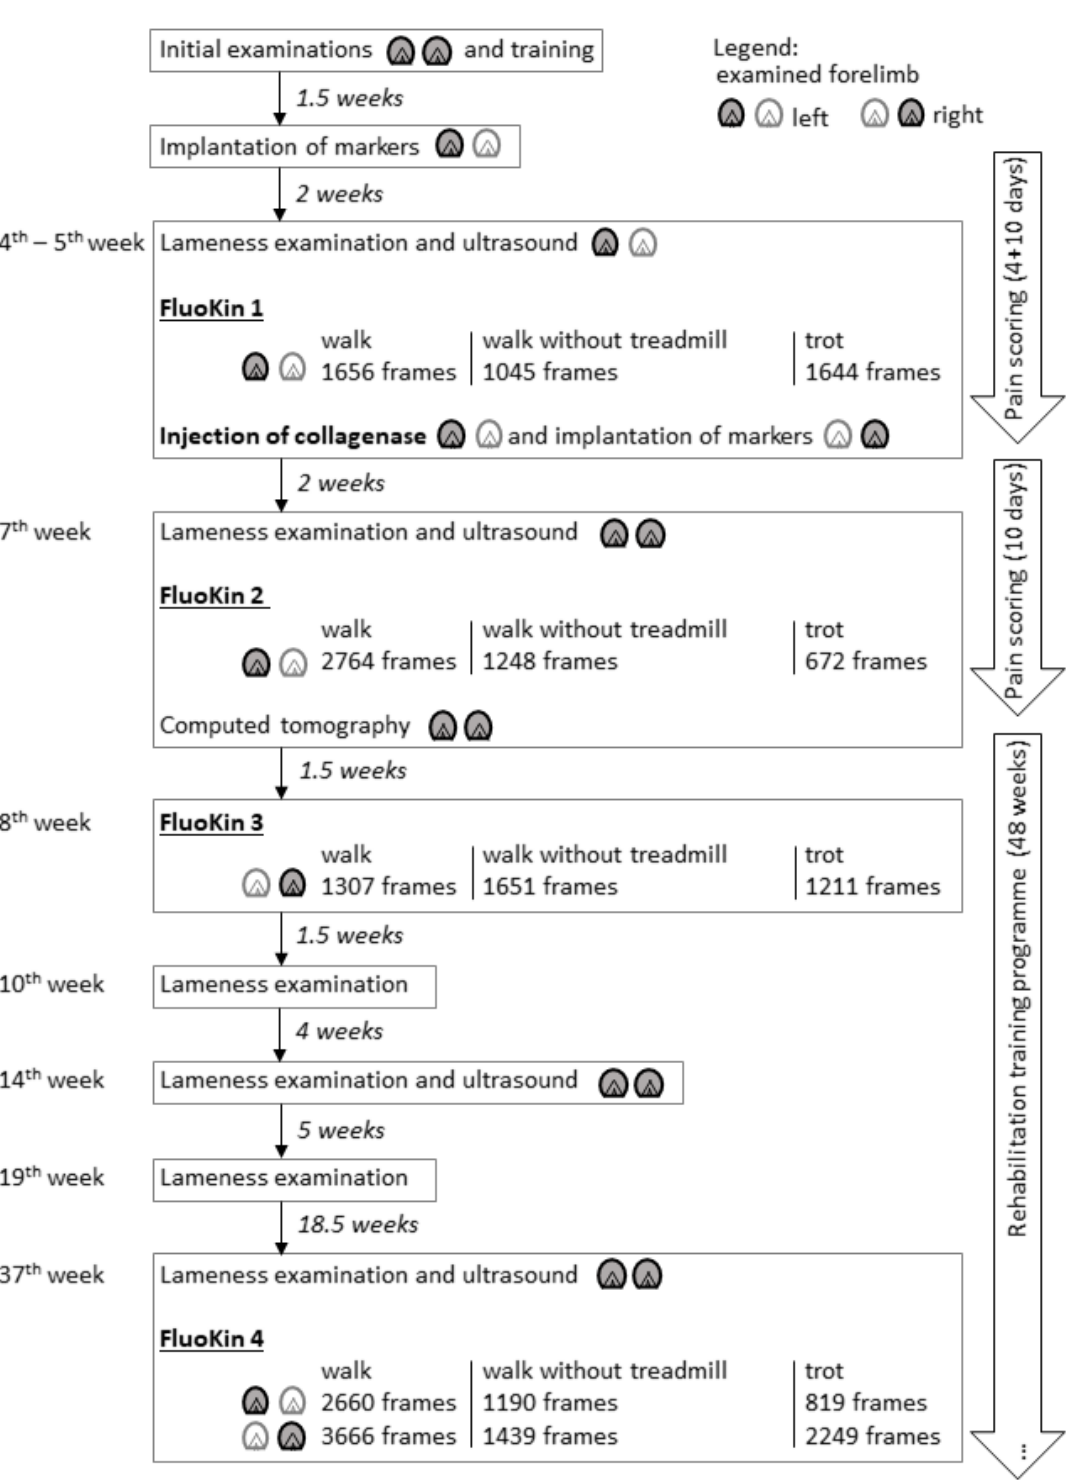
Figure 1. Time schedule of the experimental set-up. Additionally, short clinical examinations were carried out every day within the clinic’s routine.